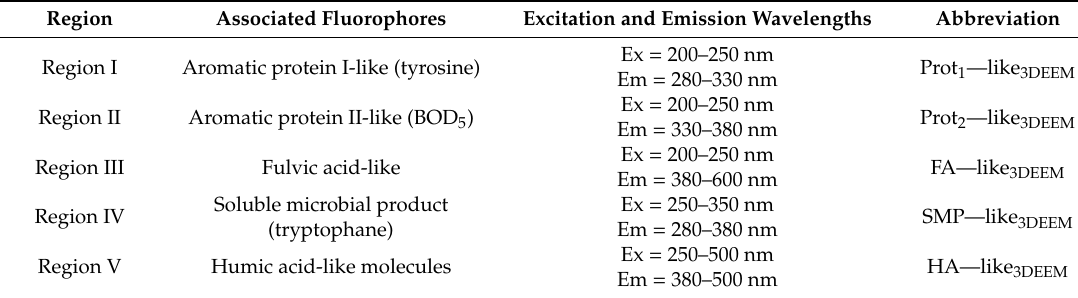
Table 3. Characteristics of the associated fluorophores detected by a 3D fluorescence excitation–emission matrix (3DEEM), according to W. Chen et al.